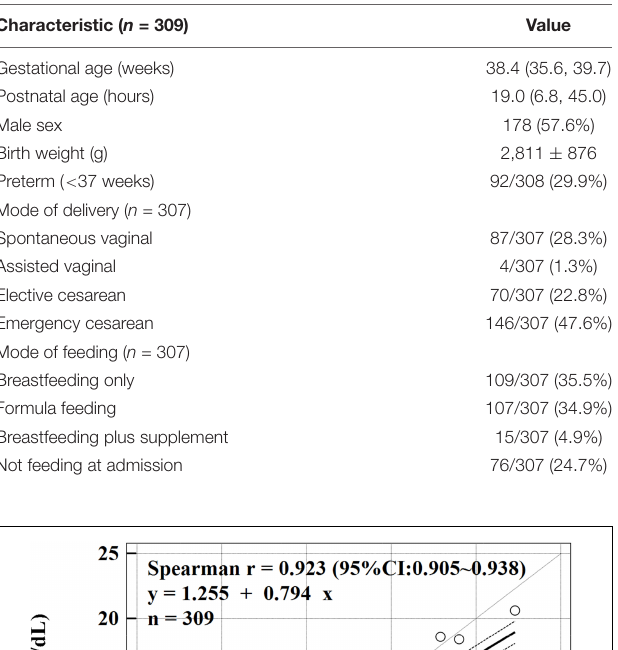
TABLE 1 | Characteristics of the study population.